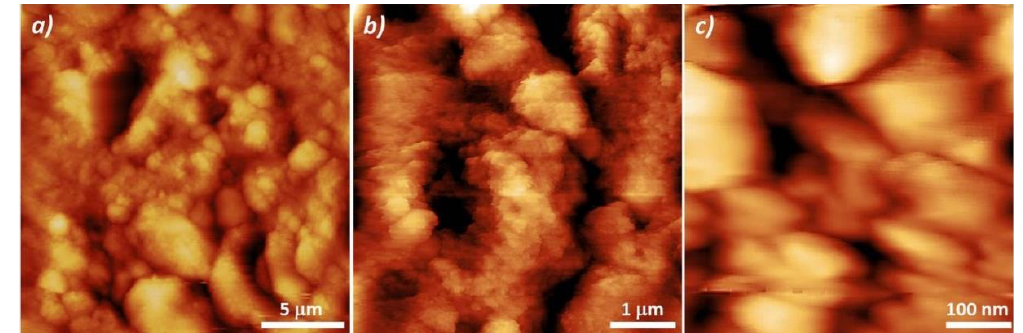
(Ra: 140 ± 85 nm) appeared densely packed with a series of void spaces (darker areas), due to their uneven boundaries.